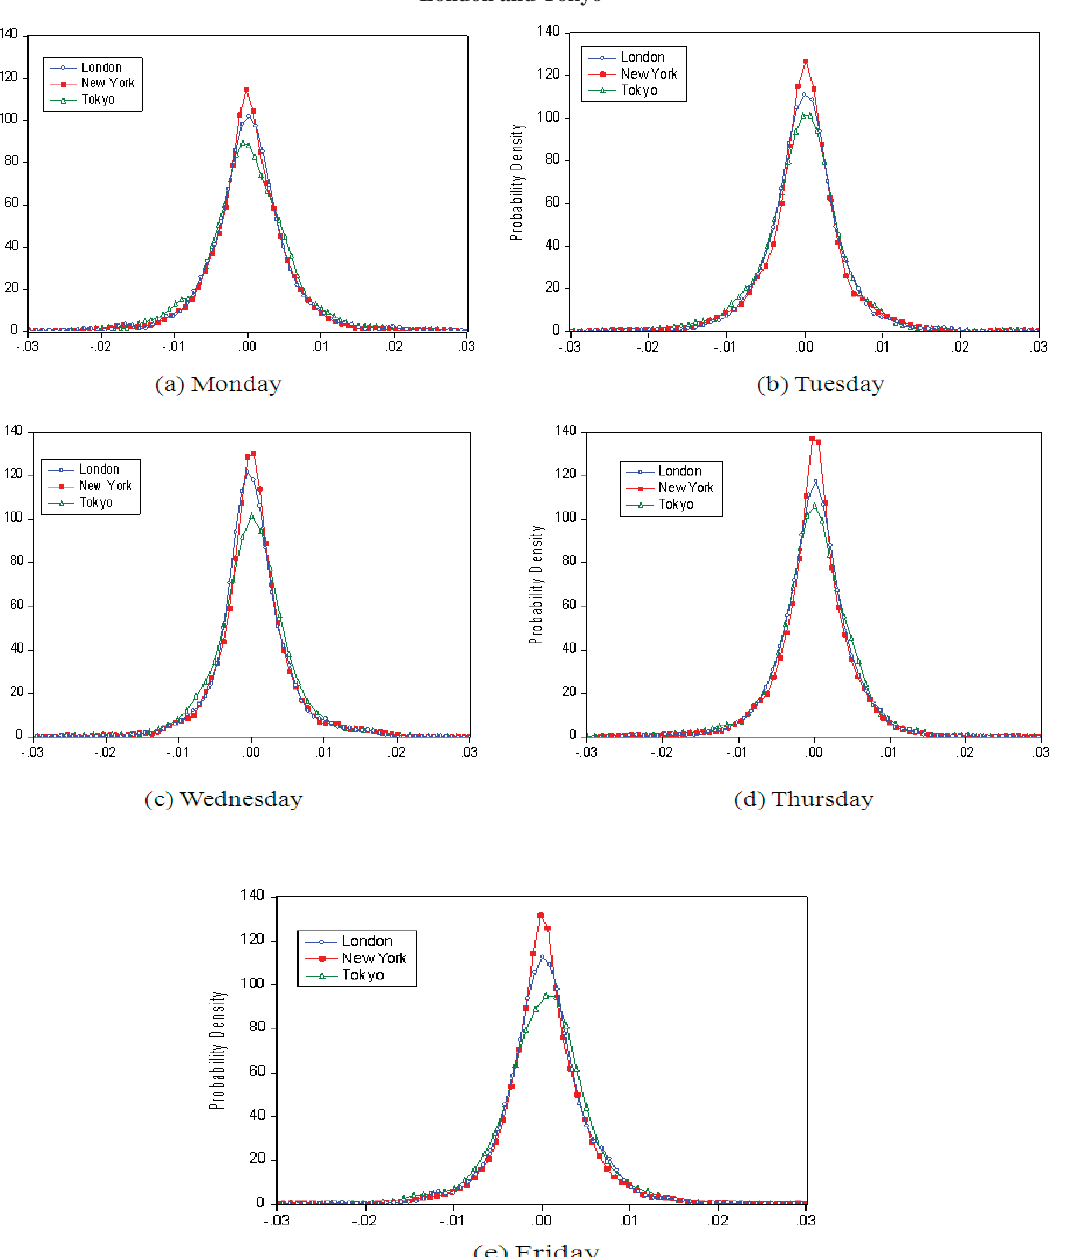
Fig. 4(a). Two-dimensional and (b) three-dimensional weekday returns from Monday to Friday in New York,